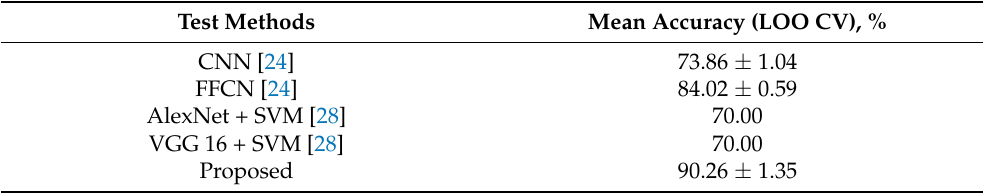
Table 3. Comparison of proposed technique with earlier techniques using LOO CV test on MU dataset.